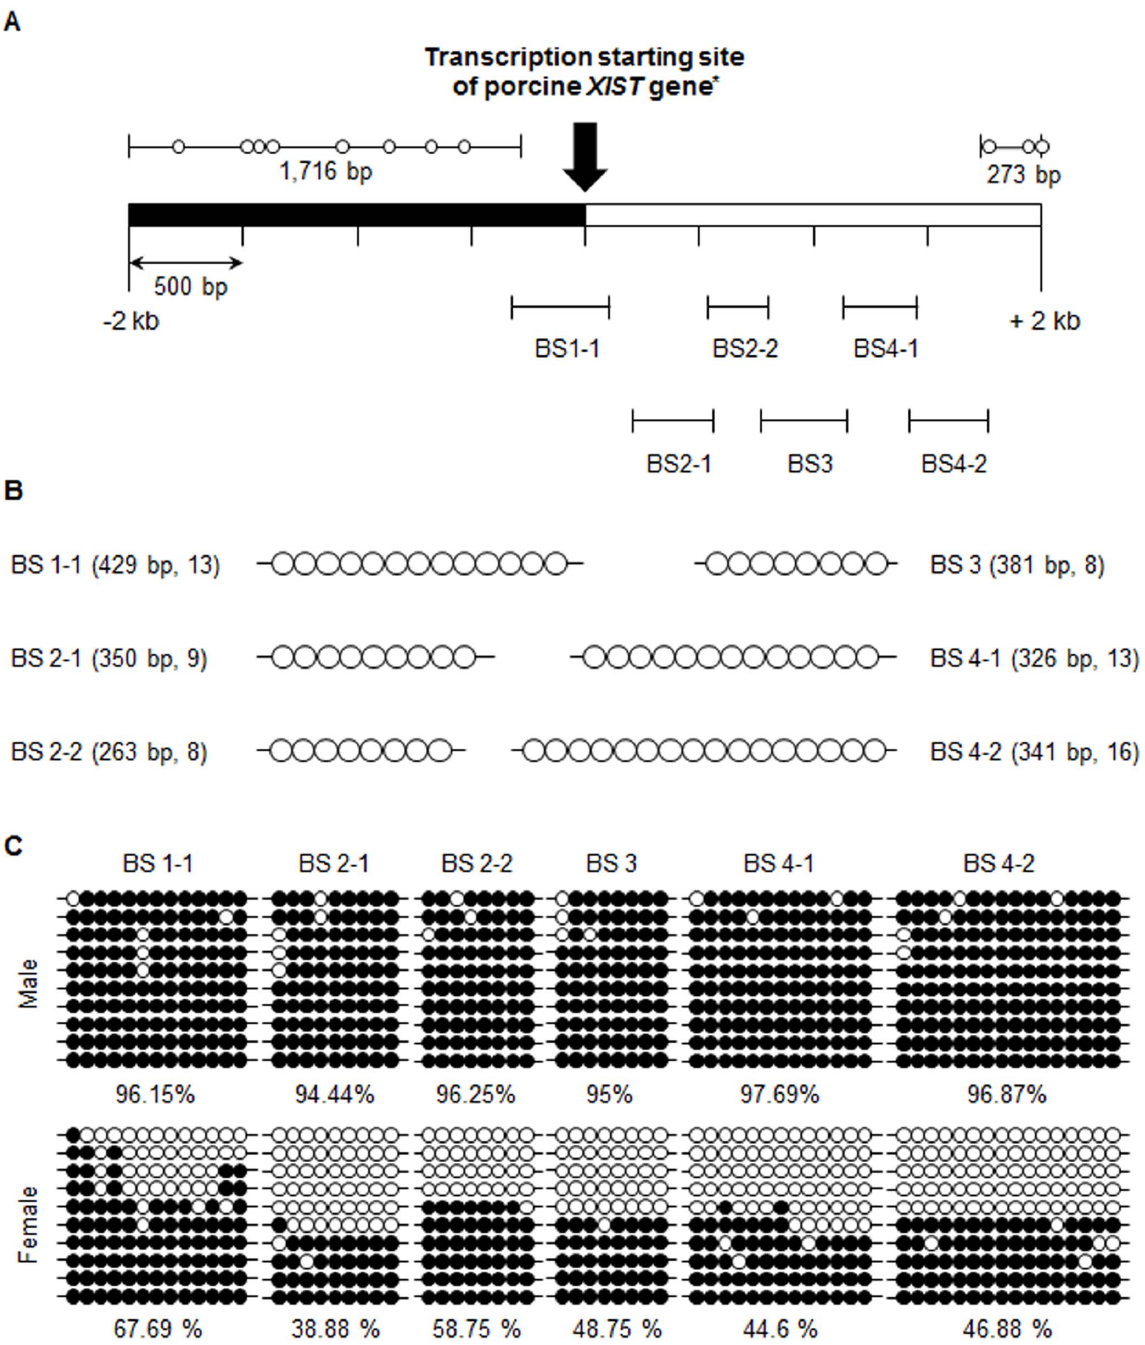
Figure 4. Diagram of the CpG sites located in the ± 2 kb region of the transcription start site of porcine XIST and the methylation status of XIST CpG sites in male and female porcine embryonic fibroblasts. (A) One of the transcription start sites (TSS) identified by 5`-RACE- PCR was set as a + 1 (asterisk, 289233 rd nucleotide of NW_003612825.1). Black and empty bars indicate regions upstream and downstream of the TSS, respectively. Methylation of CpG sites in six regions (BS1-1, BS2-1, BS2-2, BS3, BS4-1, and BS4-2) was analyzed. The diagram is scaled. (B) Profiles of the six target regions. Each circle represents a single CG dinucleotide identified in the amplified region. The length of each amplicon was 250 bp –450 bp and contained between 8–16 CG dinucleotides. The diagram is not scaled. (C) The methylation status of 67 XIST CpG sites were analyzed in male and female embryonic fibroblasts. Each circle indicates a CpG dinucleotide. Filled and empty circles represent methylated and unmethylated CpG dinucleotides, respectively. The horizontal line represents one individual clone.